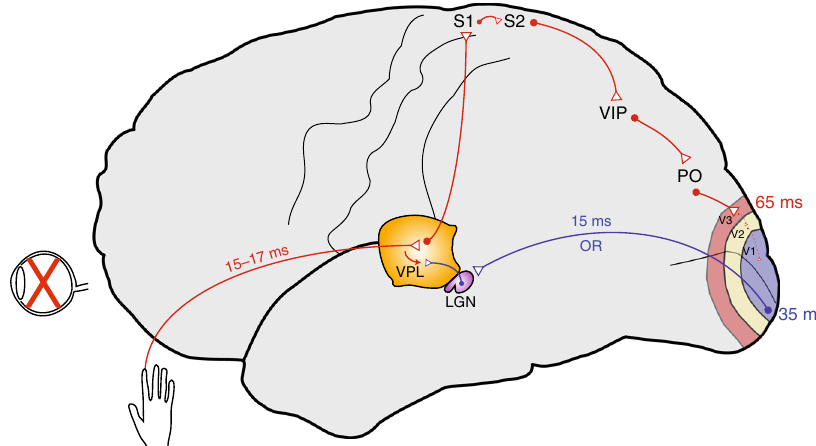
Fig. 4 Proposed scheme showing tactile information fl ow to the occipital cortex. Tactile information from large myelinated (A β ) afferents is sent to the VPL and then rerouted to the LGN, from which it is further relayed to the primary visual cortex via the optic radiations. This de novo pathway (in blue) allows fast transmission of tactile information to the occipital cortex in congenitally blind subjects, as witnessed by short occipital response times around 35 ms. Tactile information can also be rerouted via a strengthening of an existing cortico-cortical pathway (in red). Tactile information is relayed from the VPL to SI, and from there further to the occipital cortex via the posterior parietal cortex. Because it involves more synapses, this is a much slower pathway, with response times around 65 ms. Abbreviations : LGN lateral geniculate nucleus, OR optic radiations, PO parietal – occipital area, S1/S2 primary/secondary somatosensory cortex, VIP ventral intraparietal area, VPL ventroposterolateral thalamic nucleus, V1 primary visual cortex, V2/V3 visual areas V2 and